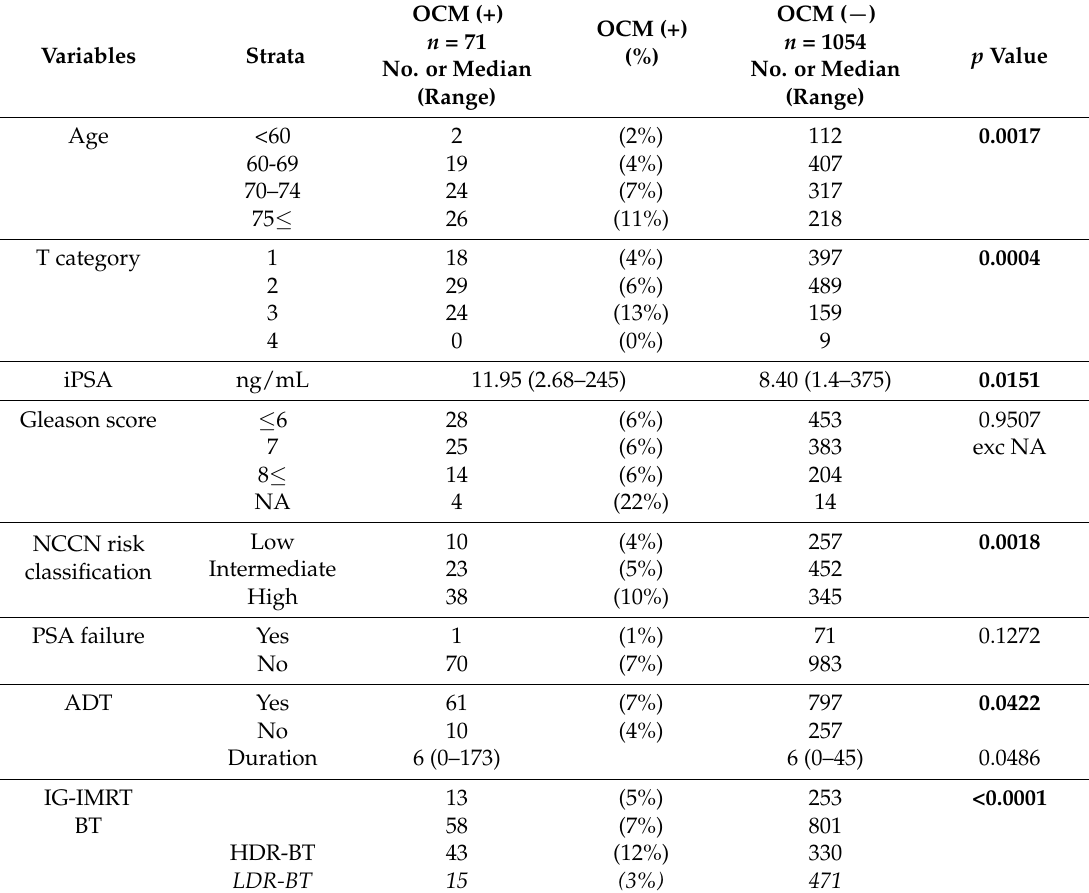
Bold values indicate statistically significance, NA; not available, ADT = androgen deprivation therapy, HDR-BT; high-dose-rate brachytherapy, LDR-BT; low-dose-rate brachytherapy, iPSA = initial PSA, IG-IMRT; image guided